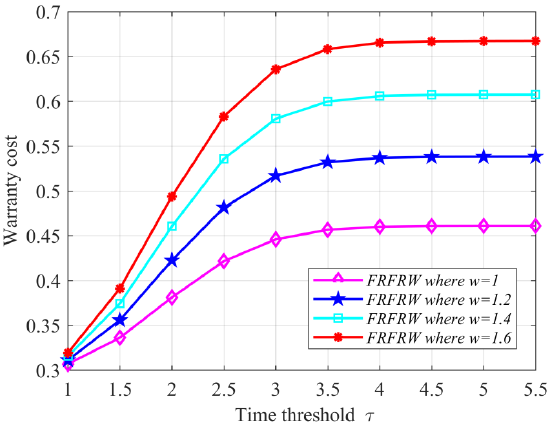
Figure 3. The impacts of τ and w on the warranty cost of the FRFRW.